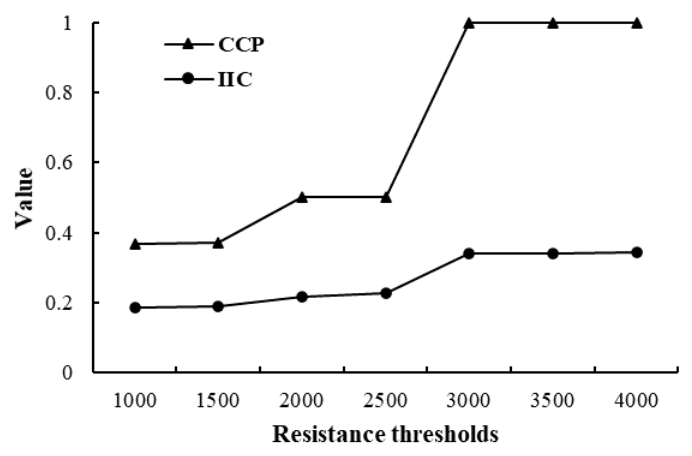
Figure 5. Integral index of connectivity (IIC) and class coincidence probability (CCP) in different resistance thresholds.